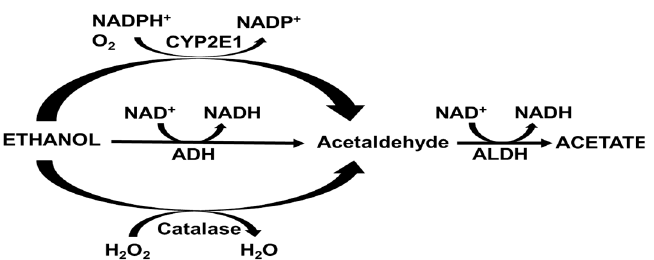
Figure 1. The major pathways of acetaldehyde formation after alcohol ingestion, alcohol dehydrogenase (ADH), cytochrome P450 2E1 (CYP2E1), catalase, and aldehyde dehydrogenase (ALDH) are demonstrated with their cofactors, and substrates.